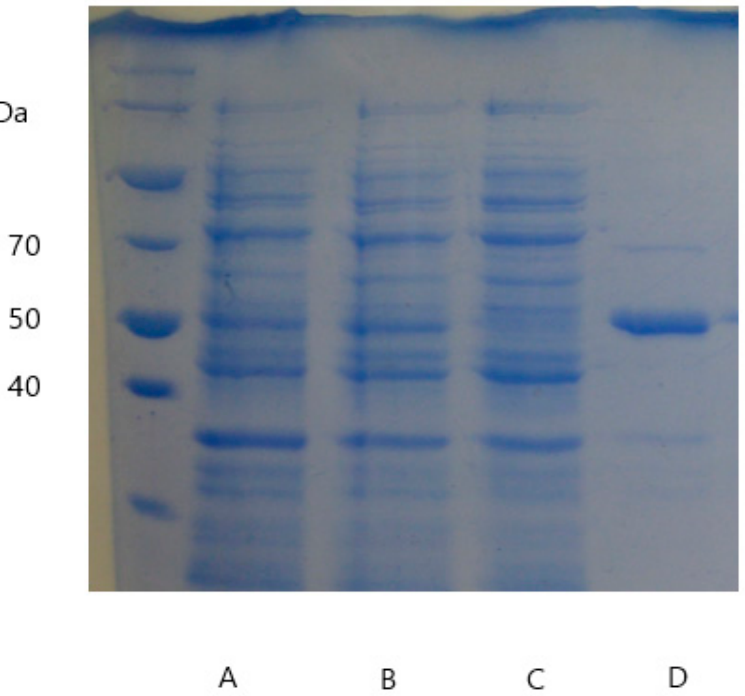
Figure A2. Results of SDS-PAGE illustrating the ( A ) crude extract, ( B ) crude extract after 500 mM NaCl, ( C ) flowthrough, ( D ) elution during the purification of DypA.